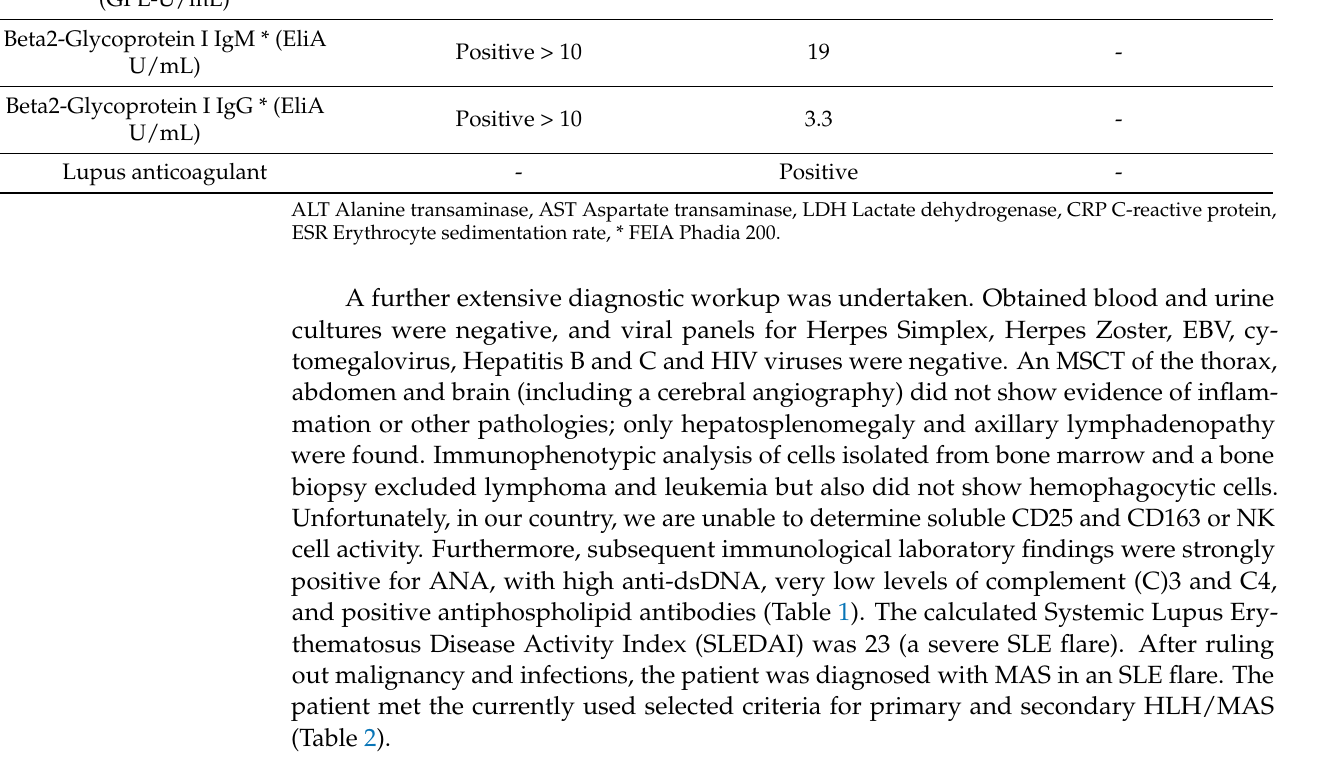
Table 2. Selected criteria for MAS/HLH currently in use and applied to our